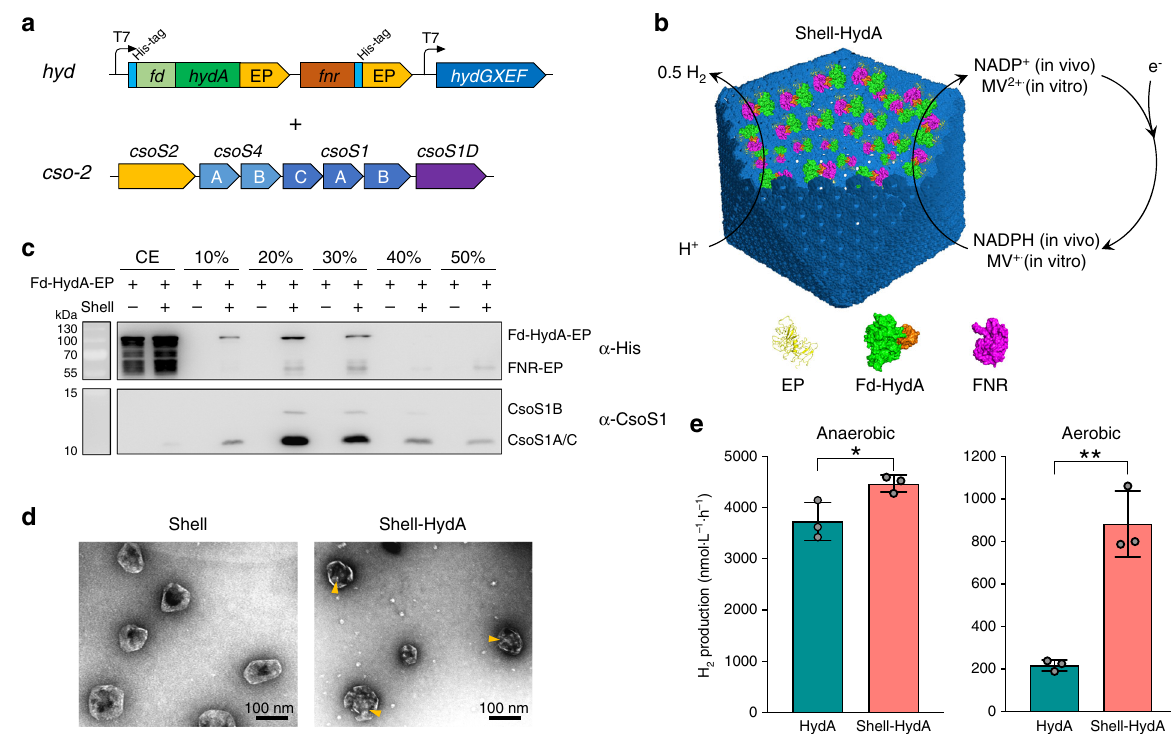
Fig. 3 Construction of a hydrogenase-containing nanoreactor based on the carboxysome shell. a Generation of the hyd operon to produce [FeFe]- hydrogenase HydA fused with ferredoxin (Fd) from the green alga Chlamydomonas , ferredoxin:NADP + -oxidoreductase (FNR) from E. coli , and the HydA maturases HydE, HydF, and HydG. The hyd and cso-2 plasmids were co-expressed to form a hydrogenase-containing nanoreactor based on the carboxysome shell (Shell-HydA). b Schematic of the Shell-HydA nanoreactor encapsulating Fd-HydA and FNR. The nanoreactors were tested for hydrogen production activity using endogenous NADPH in cells as the electron donor for in vivo assays, and for in vitro assays, using methyl viologen (MV + ) as an electron donor, which were chemically reduced by sodium dithionite. c Western blot of E. coli expressing the hyd operon alone or Shell-HydA con fi rms the presence of Fd-HydA, FNR, and shell proteins in the samples puri fi ed from sucrose gradient ultracentrifugation, indicating the assembly of Shell-HydA. d Transmission EM of empty shells (left) and Shell-HydA (right). Yellow arrows indicate cargo proteins (Fd-HydA, FNR) in the luminal side of the shell. e In vivo hydrogenase activity assays. H 2 production (nmol L − 1 h − 1 ) of E. coli cells expressing free HydA or Shell-HydA grown under anaerobic (left) or aerobic (right) conditions was measured using gas chromatography. Values represent mean ± standard deviations (s.d.), n = 3 biologically independent experiments. * p = 0.0352 (left), ** p = 0.0018 (right) (two-tailed unpaired t -test). Source data underlying c – e are provided as a Source data fi le.